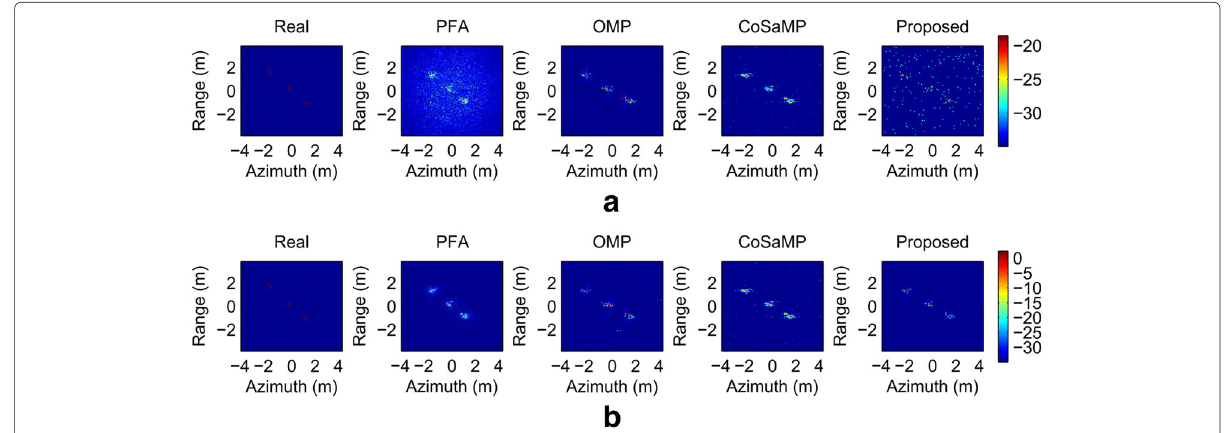
Fig. 2 SAR imaging for ideal point scatterer model under different SNRs. a SNR = 3 dB, b SNR = 30